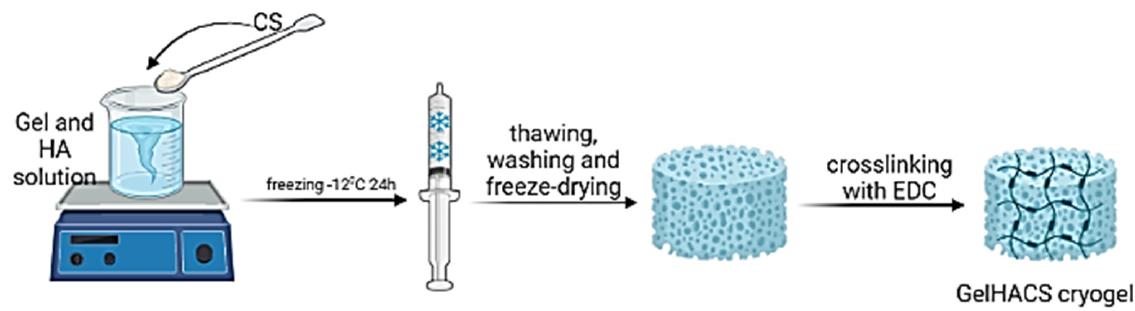
Figure 1. The scheme of a cryogel formation. Created with BioRender. Available online: http://biorender.com (accessed on 11 August 2022).